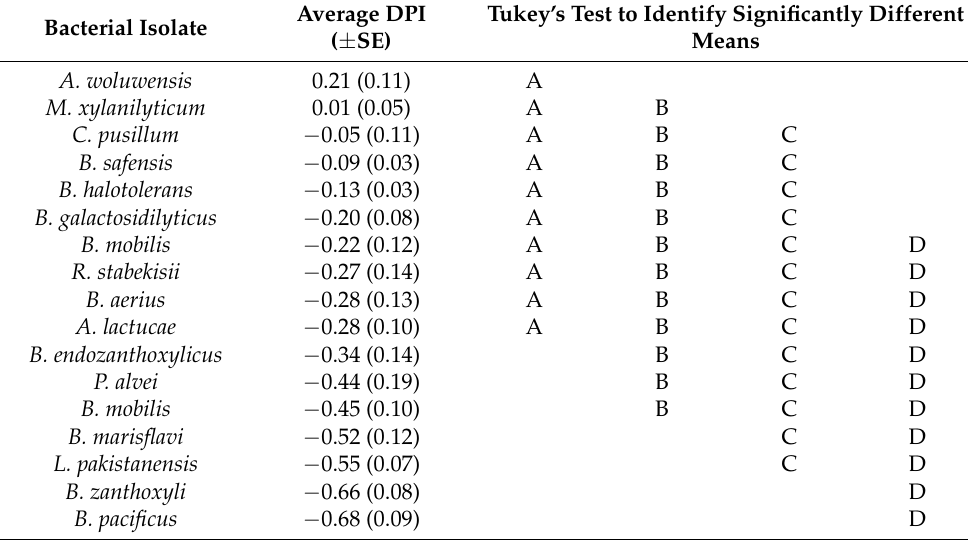
Table 4. Effects of soil-derived bacterial isolates (5 × 10 8 cells/mL) on S. invicta digging preference index (DPI) after 18